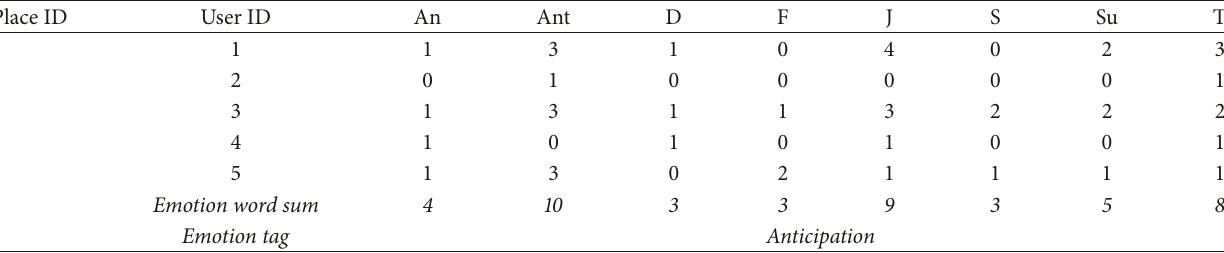
Table 3: Emotion tag derivation based on TF values.